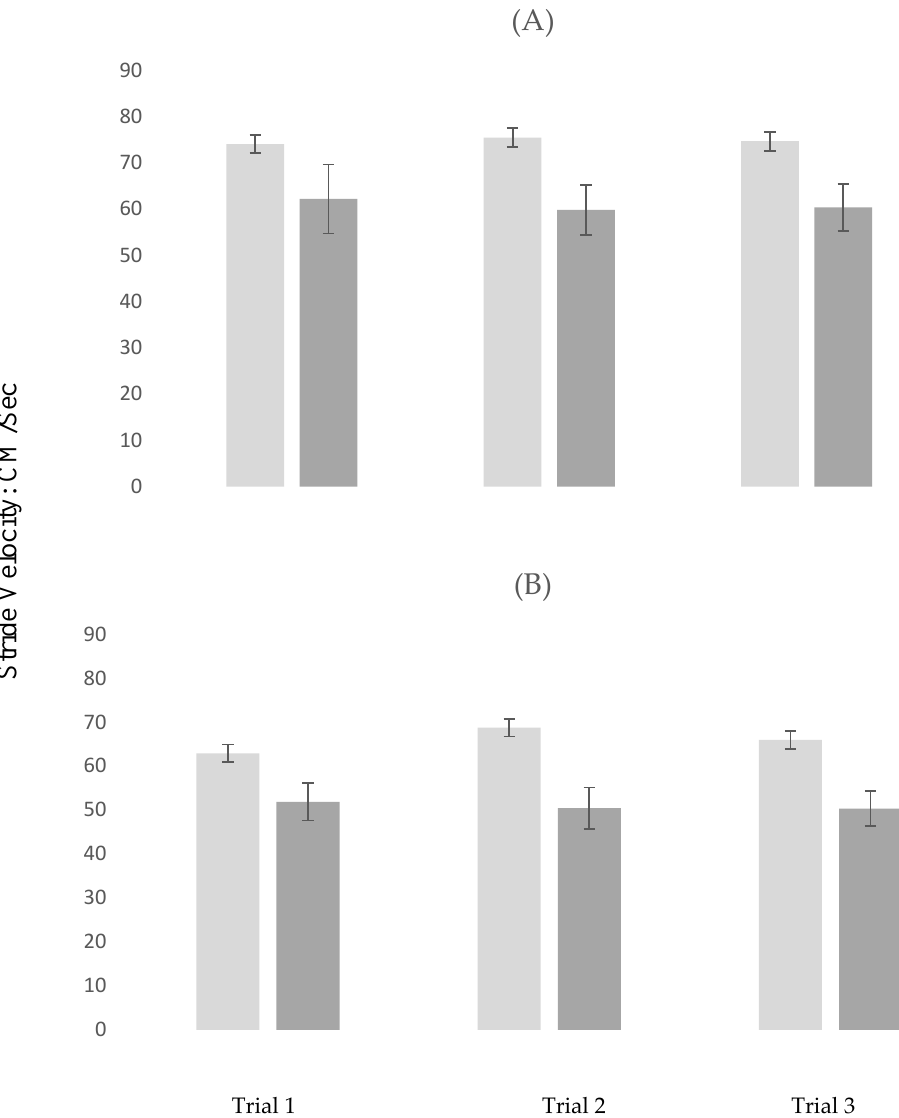
Figure 3. Changes in gait velocity across repeated trials stratified by task conditions in MCI and control participants. Light Grey: Control Participants; Dark Grey: MCI Participants; ( A ) repeated Trials in STW (Single-Task-Walk); ( B ) repeated Trials in DTW (Dual-Task-Walk); MCI = Mild Cognitive Impairments .